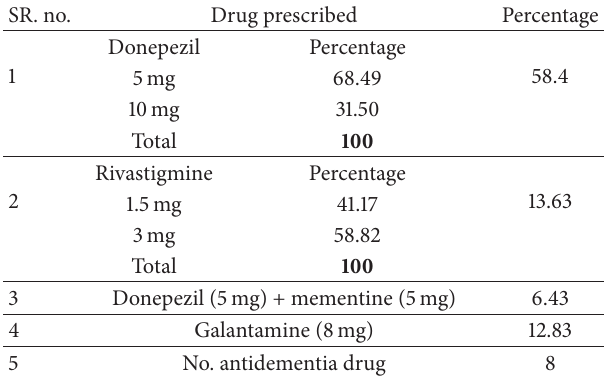
Table 5: Depiction of dose distribution of different antidementia drugs used.